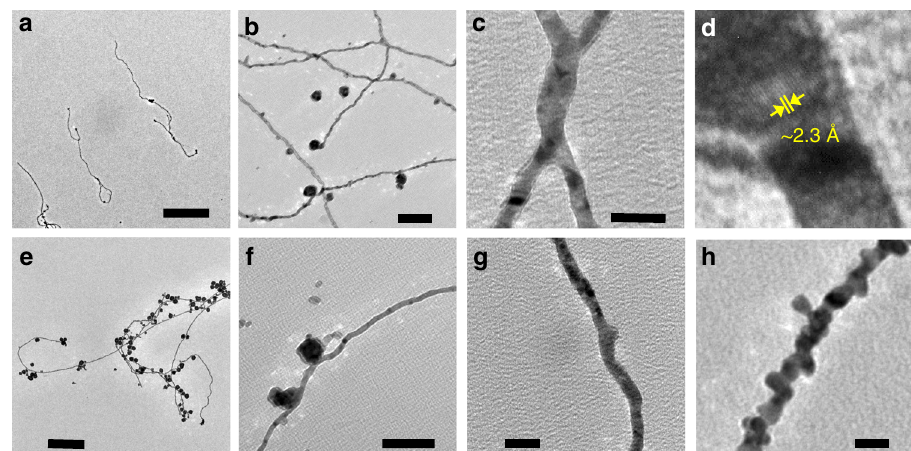
Fig. 3 Reducing-agent-free and template-free synthesis of Au nanowires (AuNWs) in the aqueous microdroplets. a AuNWs with several micrometer length. Scale bar is 1 µ m. b Formation of AuNW network. Scale bar is 100 nm. c Junction between two AuNWs. Scale bar is 20 nm. d A TEM image showing the lattice spacing of ~2.3 Å, corresponding to the Au(111) structure, con fi rming that the nanowire is made of pure Au. e , f AuNWs accompanying with AuNP and AuNP aggregates. Scale bars for e and f are 300 nm and 100 nm. g , h Two different types of AuNWs formed in the microdroplets with a smooth surface ( g ) and beaded surface ( h ). Scale bars for g and h are 20